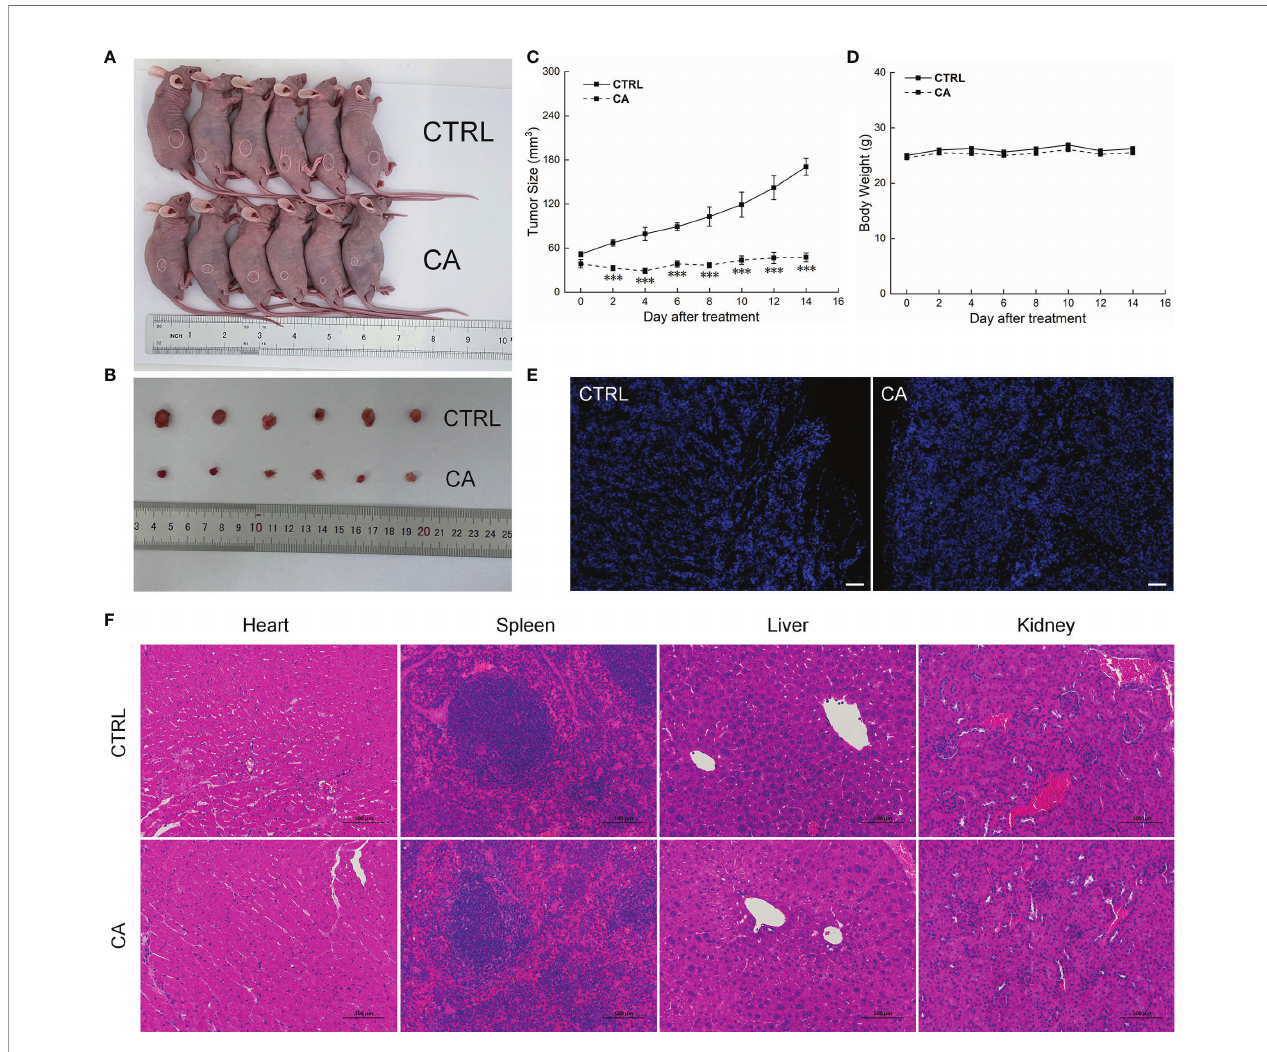
FIGURE 4 | CA treatment inhibited the tumor growth in BALB/c nude mice transplanted with CAL27 cells. CA treatment signi fi cantly reduced tumor volumes in (A) tumor-bearing BALB/c nude mice and (B) tumor tissues collected from the control (CTRL) and CA-treated groups and (C) decelerated the tumor growth without affecting (D) the body weight of the mice ( n = 6). (E) The apoptosis of tumor tissues increased after CA treatment ( n = 3) (200× magni fi cation, scale bar: 50 m m), while (F) the heart, spleen, liver, and kidney showed no histological abnormality ( n = 3) (200× magni fi cation, scale bar: 100 m m). Green fl uorescence locates apoptotic cells. The data are expressed as mean ± SEM. *** P < 0.001 versus the CTRL